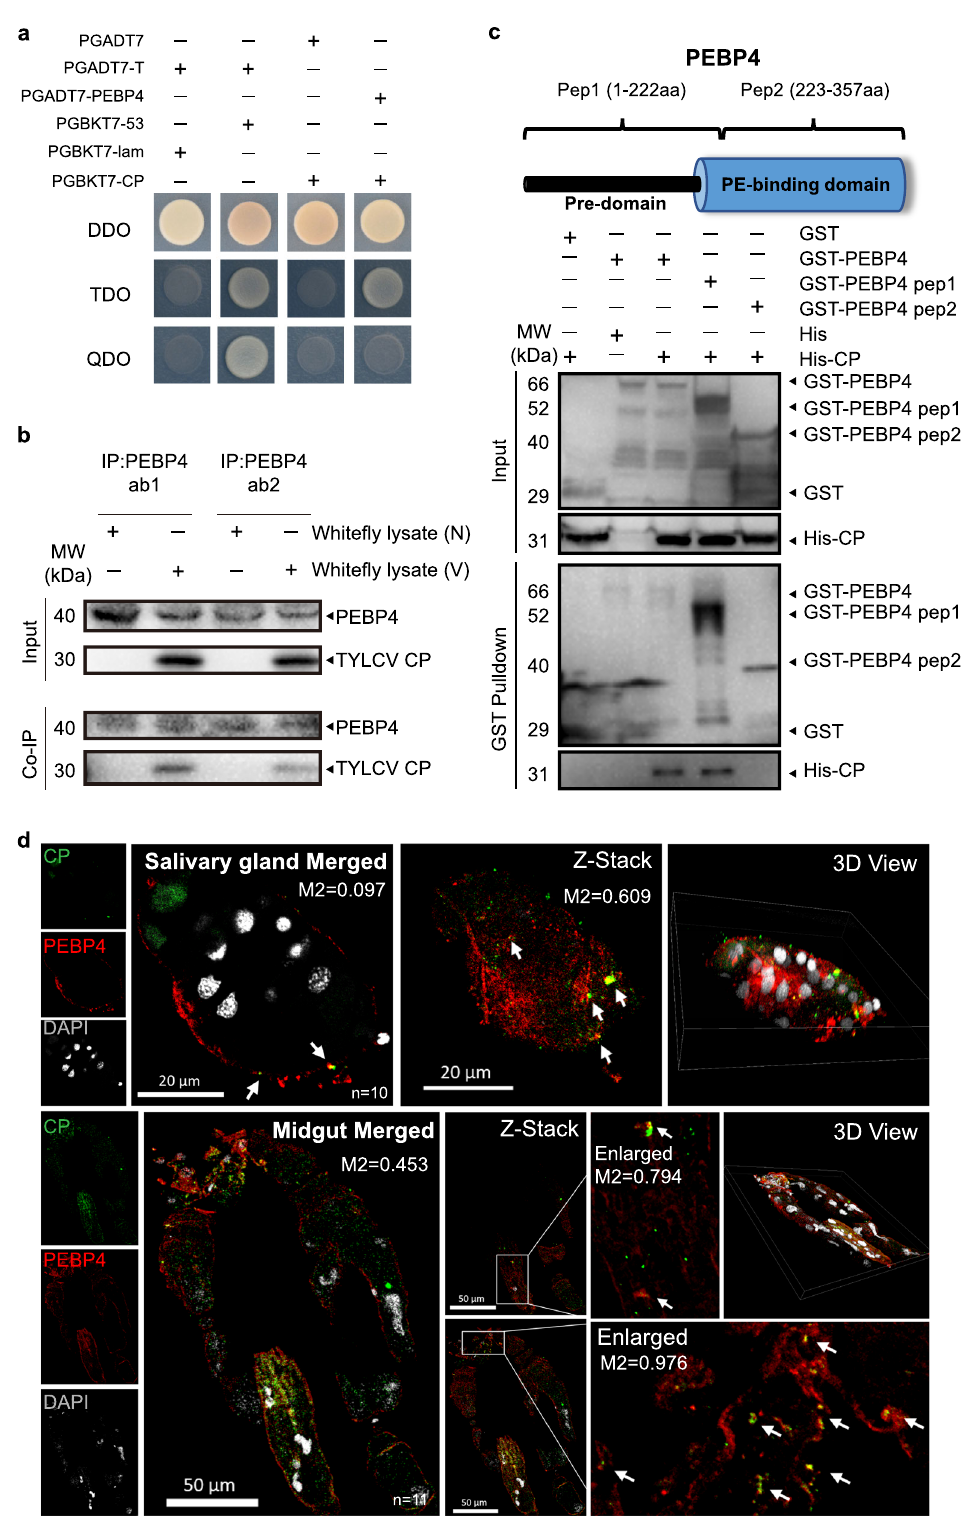
relays PEBP regulatory information on apoptosis 36,37 . All mem- bers of the human PEBP family are capable of regulating the MAPK cascade 38 – 42 . To investigate the role of white fl y PEBP4 in TYLCV-induced apoptosis, we examined if there existed direct interaction between PEBP4 and Raf1, in vivo and in vitro. GST pull-down and Co-IP assays showed that PEBP4 interacted with Raf1 via its conserved PE-binding domain whether CP was